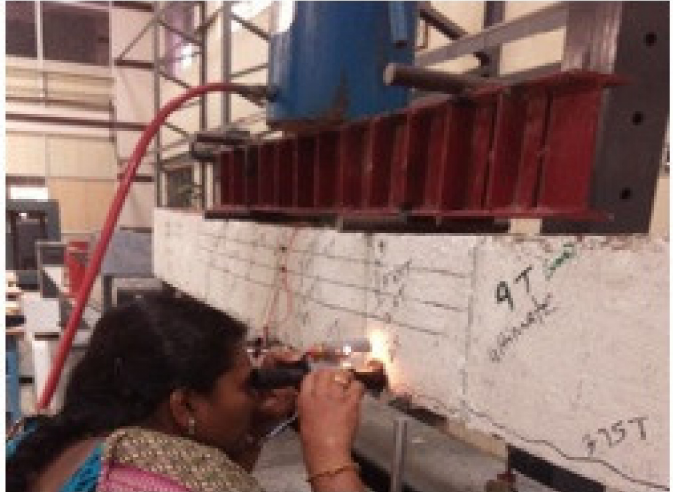
Figure 13. SCS beam with shear studs under flexural test (during